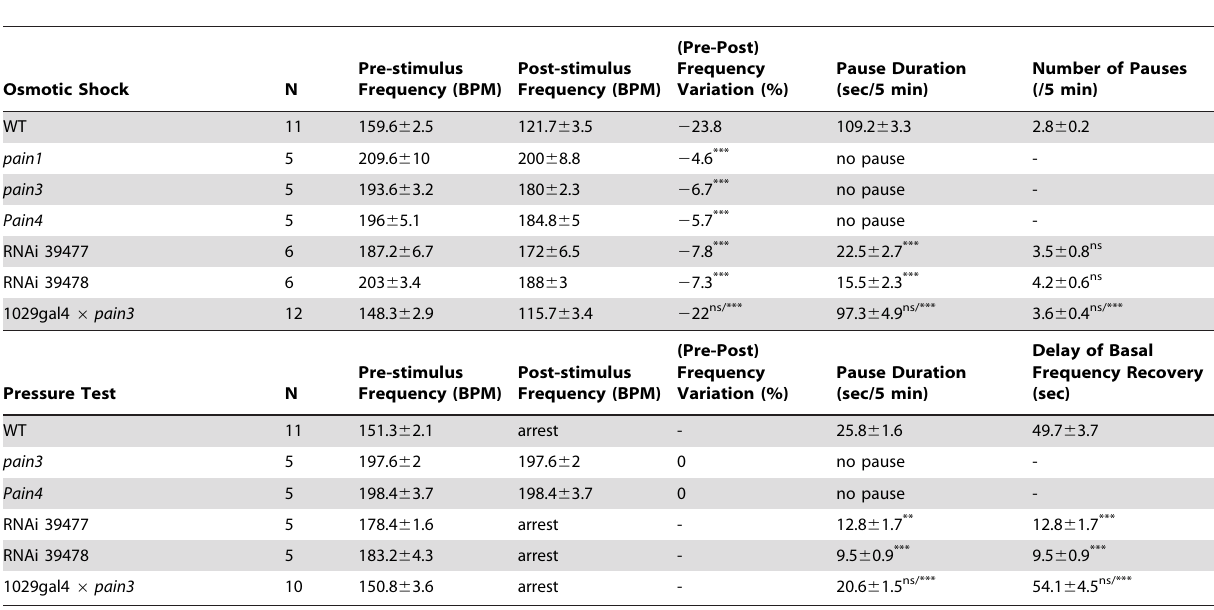
Table 1. Averaged characteristics of cardiac defects following mechanical stimuli.